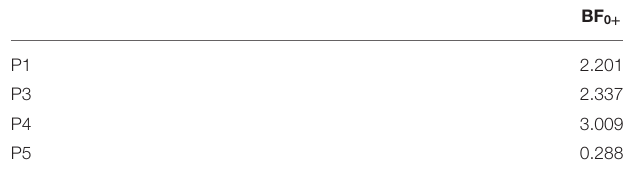
TABLE 3 | Bayesian one-sample t tests (H1 A ) on subject level.